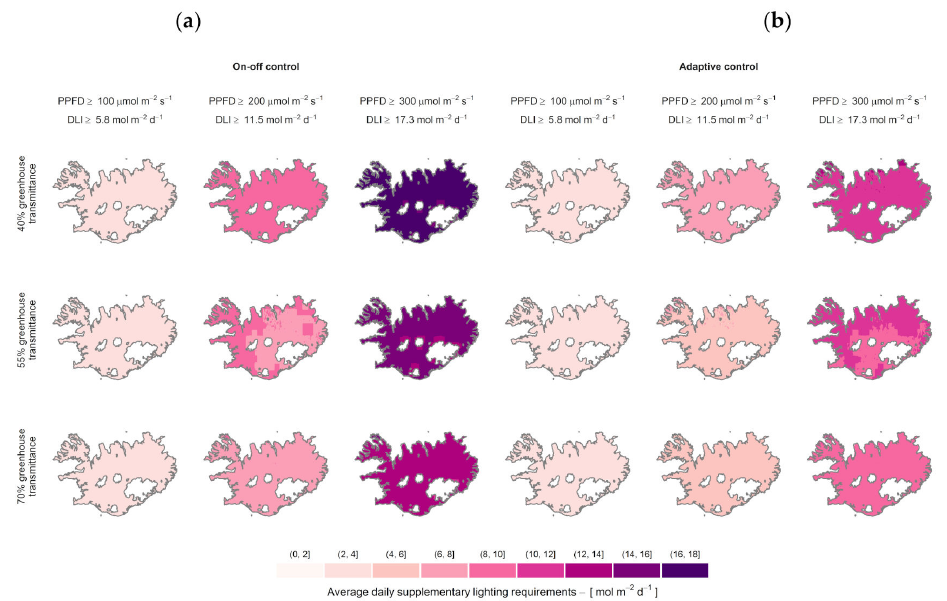
Figure A4. Average daily supplementary lighting requirements (DLI lamps , mol · m − 2 · d − 1 ) maps of Iceland for the chosen greenhouse cultivation period of 181 days: from 1 February to 20 May and from 20 August to 31 October. A photoperiod of 16 h · d − 1 was assessed considering three minimum light settings (PPFD threshold : 100, 200 or 300 µ mol · m − 2 · s − 1 ) and three possible greenhouse hemispherical transmittances ( τ h, PAR : 40%, 55% or 70%). The two panels compare different control protocols: ( a ) On-off control vs. ( b ) Adaptive control. Values presented as a 0.05 ◦ × 0.05 ◦ grid both in latitude and longitude, extending from 63 ◦ N to 67.5 ◦ N in latitude and 13 ◦ W to 25 ◦ W in longitude.